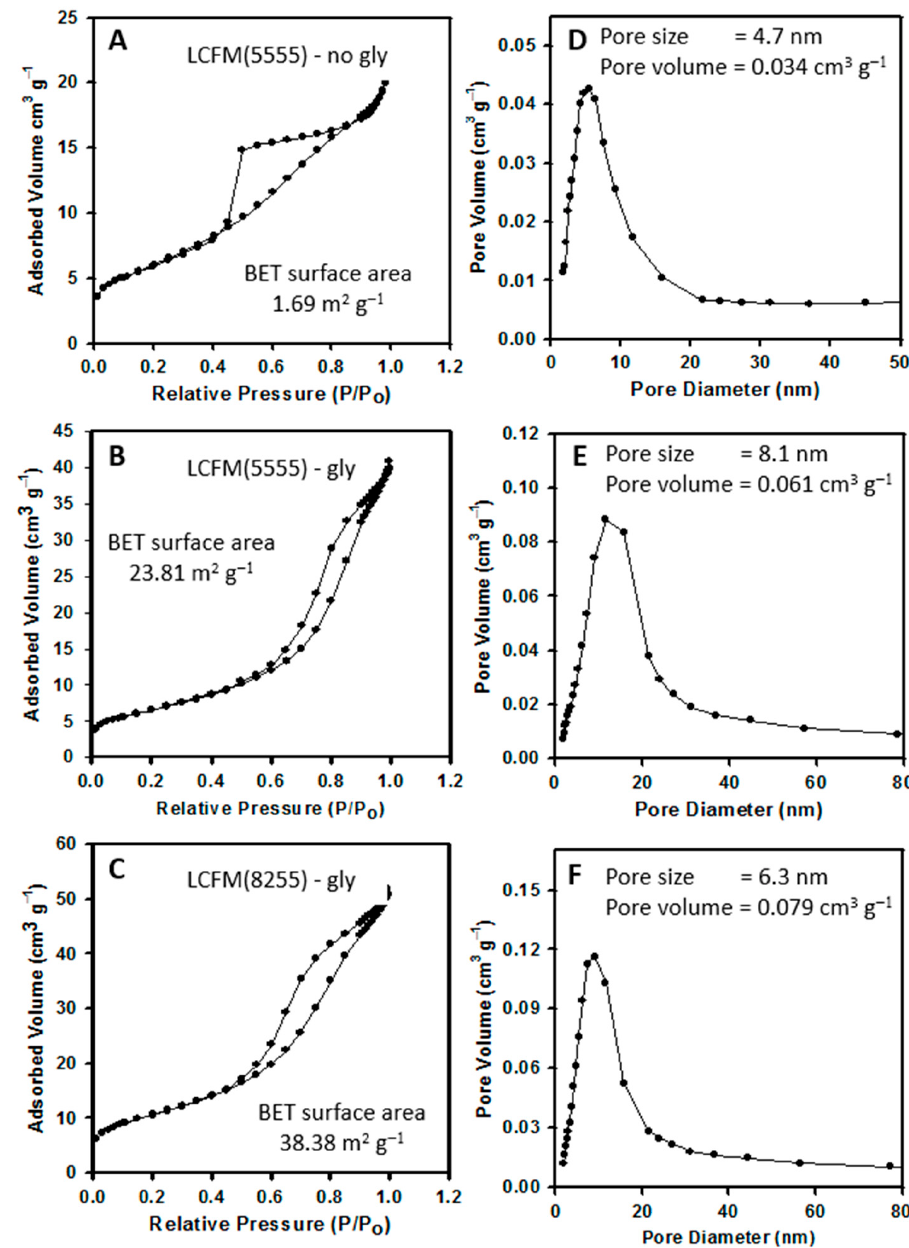
Figure 2. ( A – C ) N 2 adsorption–desorption and ( D – F ) pore-size distribution curves of LCFM(5555)-no gly, LCFM(5555)-gly and LCFM(8255)-gly catalyst samples.